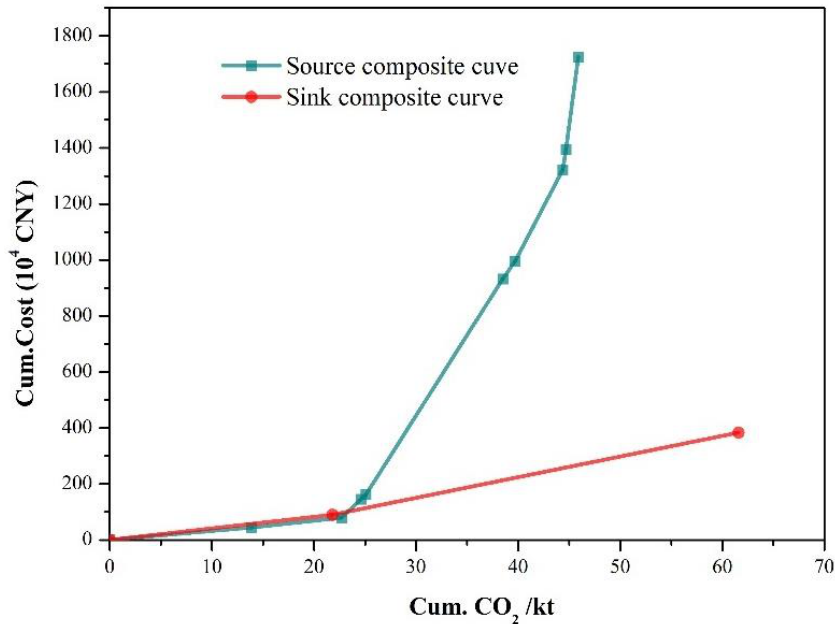
Figure 3. Source – sink curve of the tobacco industry for Scenario 1. Figure 3. Source–sink curve of the tobacco industry for Scenario